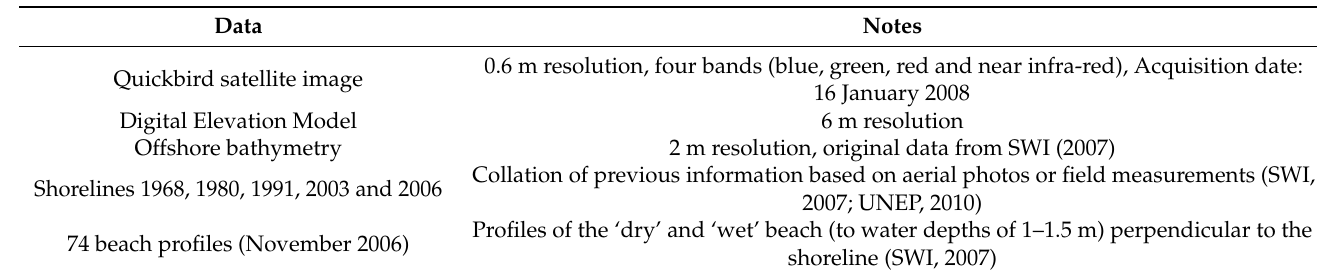
Table 1. Geospatial data